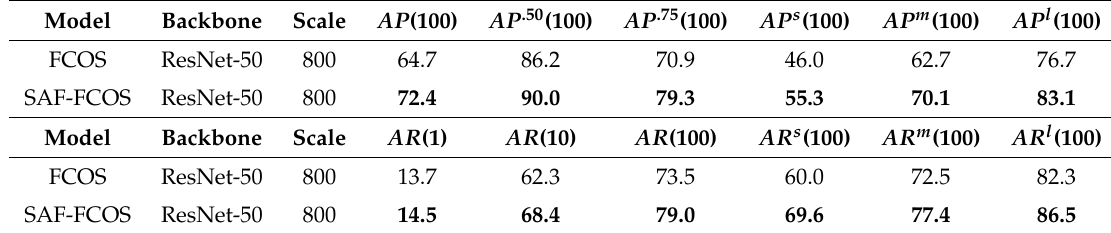
Figure 9. The detection performance comparison between FCOS [10] and SAF-FCOS in sunny, rainy and night. The images in the top row are detection results by FCOS, and the images in the bottom row are detection results by SAF-FCOS. The comparisons demonstrate that the proposed SAF-FCOS has a better performance in small and far away obstacles. Table 1. Obstacle detection comparisons using different sensors on the nuScenes test dataset [37]. The top sub-table is about average precision metrics. In addition, the bottom sub-table is about average recall metrics. The bold in every column indicates the highest